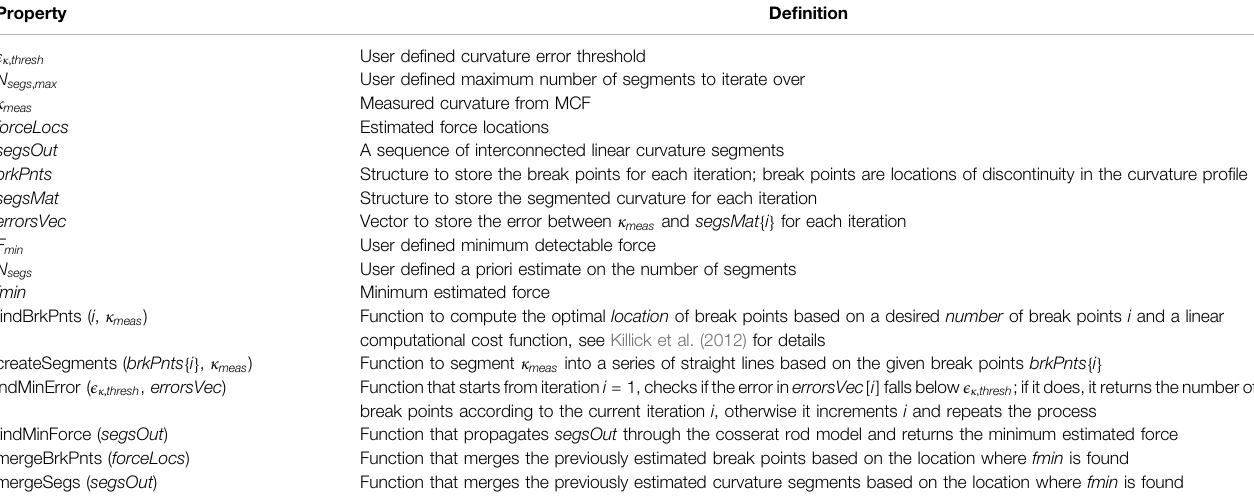
TABLE 1 | De fi nition of elements in the different algorithms.